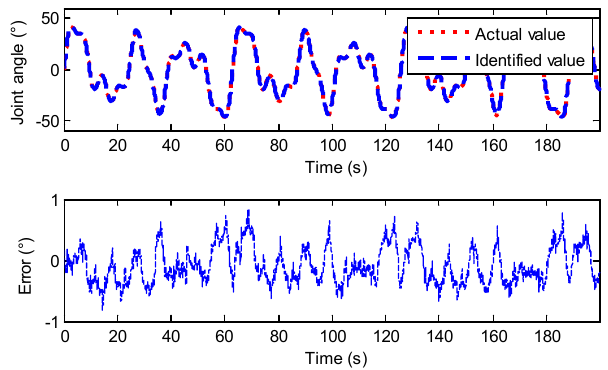
Figure 9. Identification result of the joint angle estimator model.